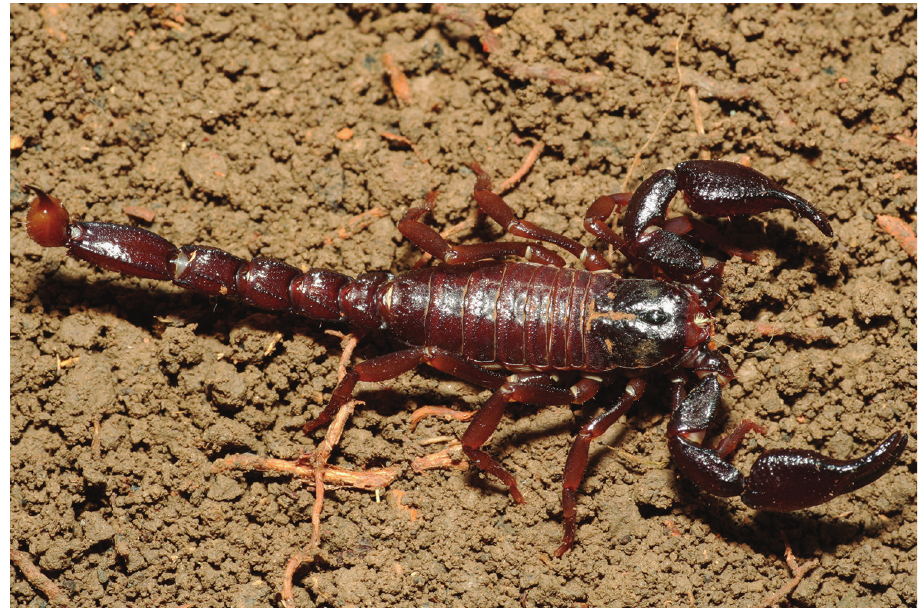
Figure 23. Brotheas gervaisii , male from Matoury. path, three males, deposited in the RNA, J. Chevalier coll., XI/2017. Awala Yalimapo, Kanawa path, one male, deposited in the RNA, J. Chevalier coll., 03/VIII/2017. Mana, path of the Forêt des Sables Blancs, one male, deposited in the RNA, J. Chevalier & B. Tan coll., 08/VII/2017. Guyane, one male and one female, MNHN-RS-0741, Lafon coll., 1872. Guyane, one female, MNHN-RS-3308, Le Moult coll., 1910. Guyane, one male, MNHN-RS-0747. Guyane, one male and one female, MNHN-RS0748. Guyane, one female, MNHN-RS-3011. Guyane, one female, MNHN-RS-0737, F. Geay coll., 1900. Guyane, one male, MNHN-RS-0739, Cavalier coll., 1889. Diagnosis. Species of small to moderate size when compared with the average size of the other species within the genus, ranging from 50 to 57 mm in total length. Gen- eral coloration brown to reddish brown. Carapace reddish brown with several black spots corresponding to the granules; ocular tubercle dark, almost black. Tergites paler than the carapace, with distal edge blackish. Sternites reddish with a lighter area, yel- lowish, at the center of sternites IV and V; pectines and genital operculum yellow ochre. Metasomal segments of same color as the tergites. Vesicle reddish yellow with basis of aculeus reddish and tip of aculeus reddish black. Chelicerae yellowish with lon- gitudinal brown spots, weakly marked; fingers reddish. Pedipalps reddish with blackish pigmentation on carinae. Legs yellowish with several brown spots. Carapace slightly emarginated, almost straight; almost smooth, with few minute granules only on lateral areas; punctate. Tergites almost smooth, with scattered minute granulations. Pectinal tooth count ranging from eight to eleven in male and six to nine in female. Sternites smooth, punctate; spiracles linear, elongated. All metasomal segments with